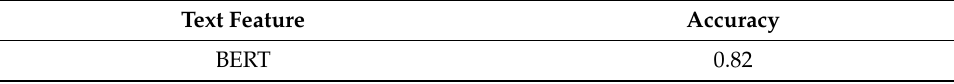
Table 5. Accuracy for text features only.